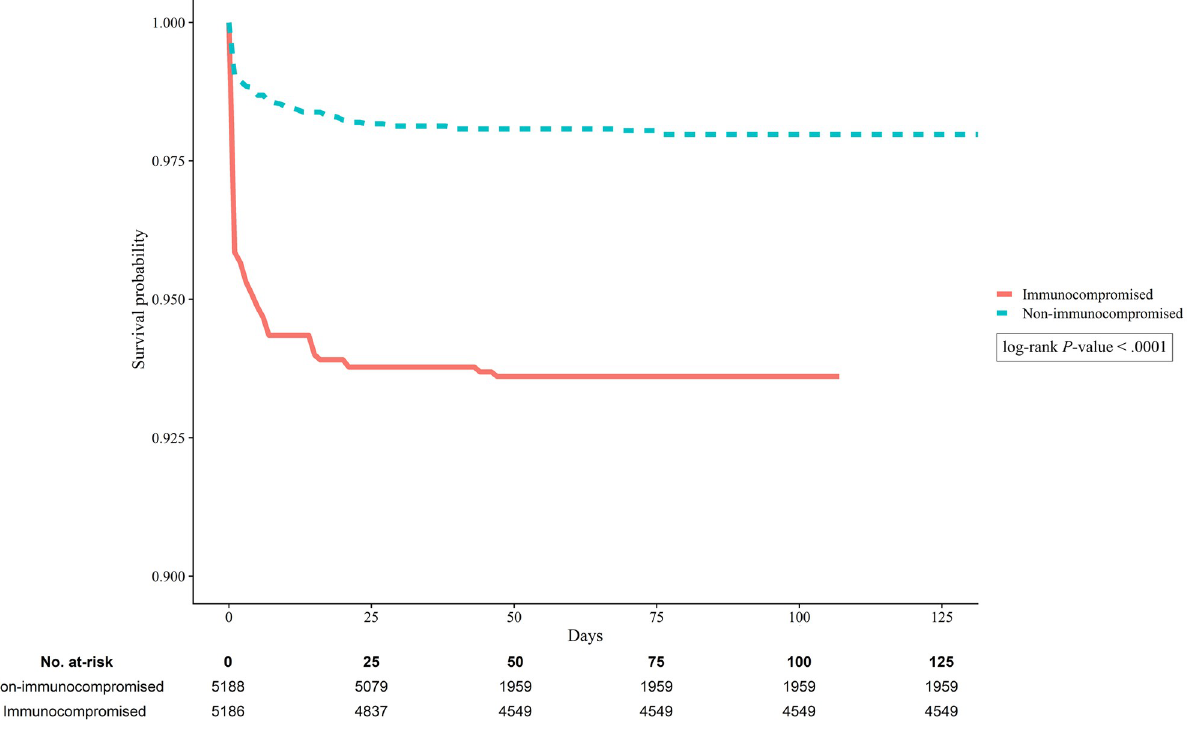
Fig 1. Kaplan-Meier survival curves for patients with COVID-19 according to immunocom-promised status after the inverse probability of treatment weighting (log-rank P-value <